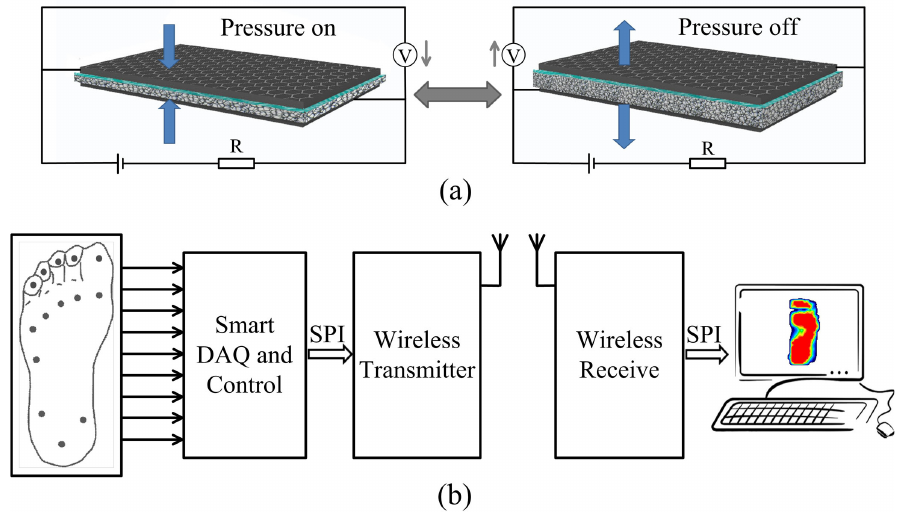
Figure 1. ( a ) The working principle of pressure-sensitive graphene textile sensor. The flexible textile acts as the support substrate and graphene layers wrapped around each polyester fiber. The thickness of textile decreases with the increasing applied pressure. ( b ) Block diagram of the proposed plantar pressure dynamic measurement